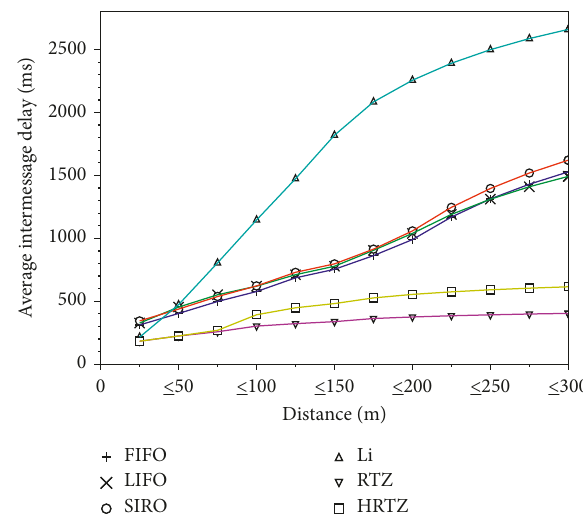
Figure 12: The intermessage delay for verified messages versus distances between